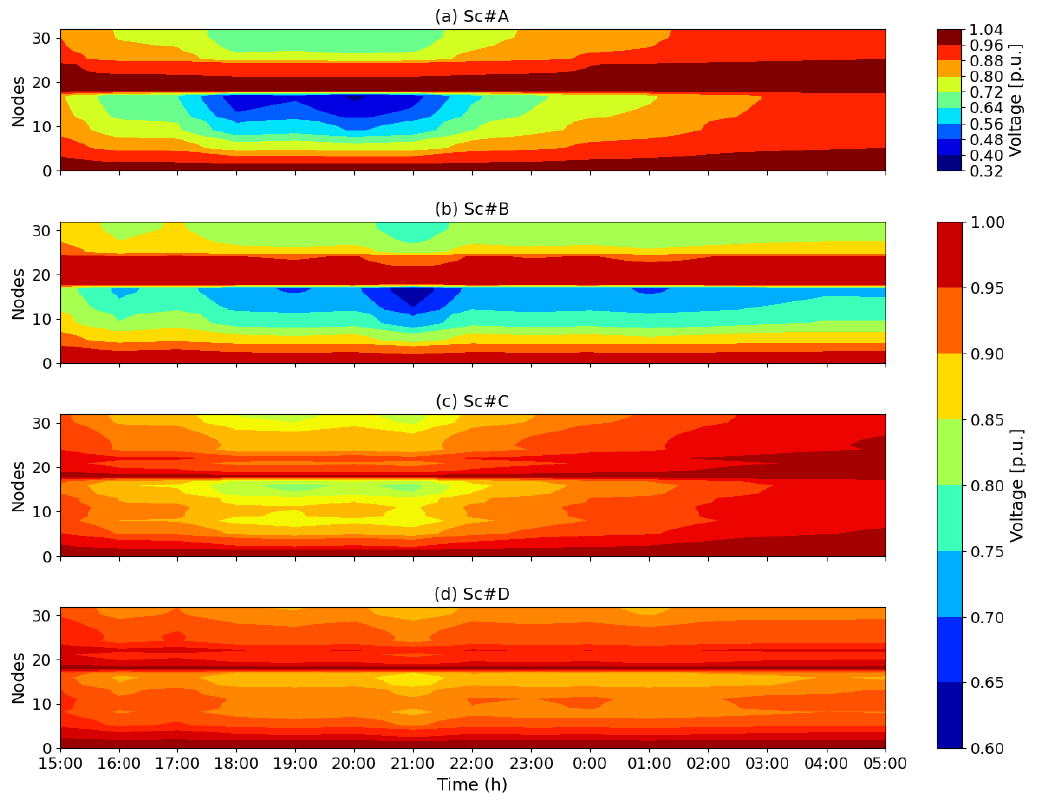
Figure 11. MV DN voltage profile for: ( a ) Sc#A, ( b ) Sc#B, ( c ) Sc#C and ( d ) Sc#D.